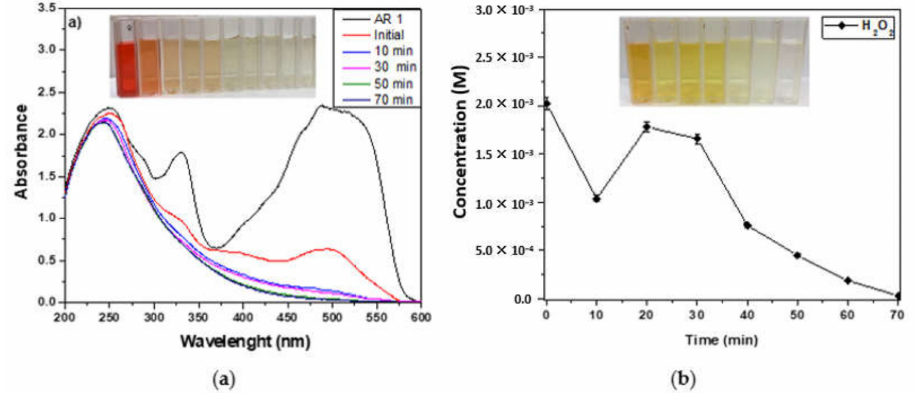
Figure 7. ( a ) UV-Visible spectra of AR 1 and ( b ) concentration of H 2 O 2 in the degradation